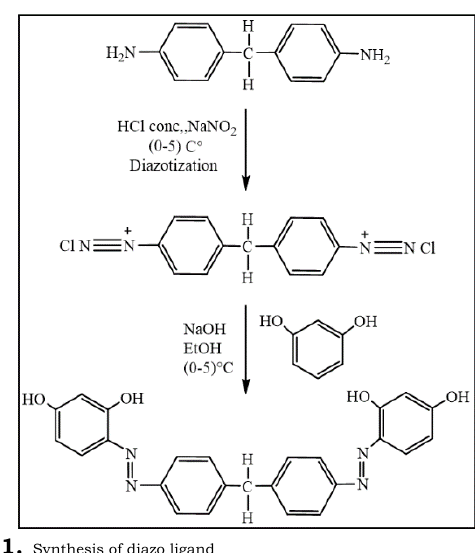
Fig. 1. Synthesis of diazo ligand